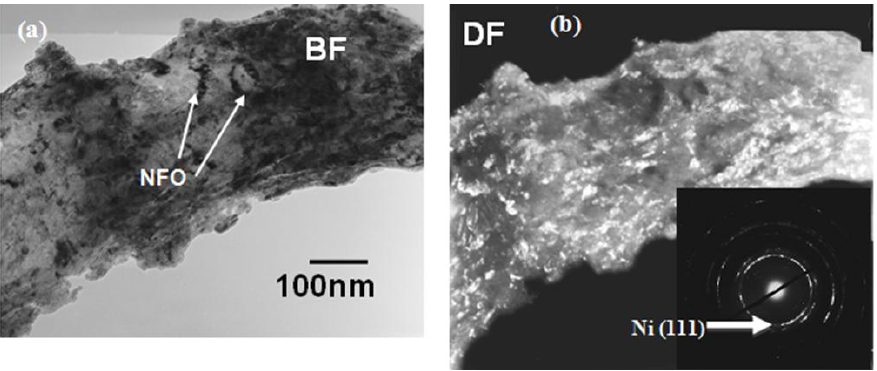
Figure 17 . Transmission electron microscope images of PZT-NFO core-shell composite synthesized by high pressure compaction sintering: (a) Bright field (b) Dark